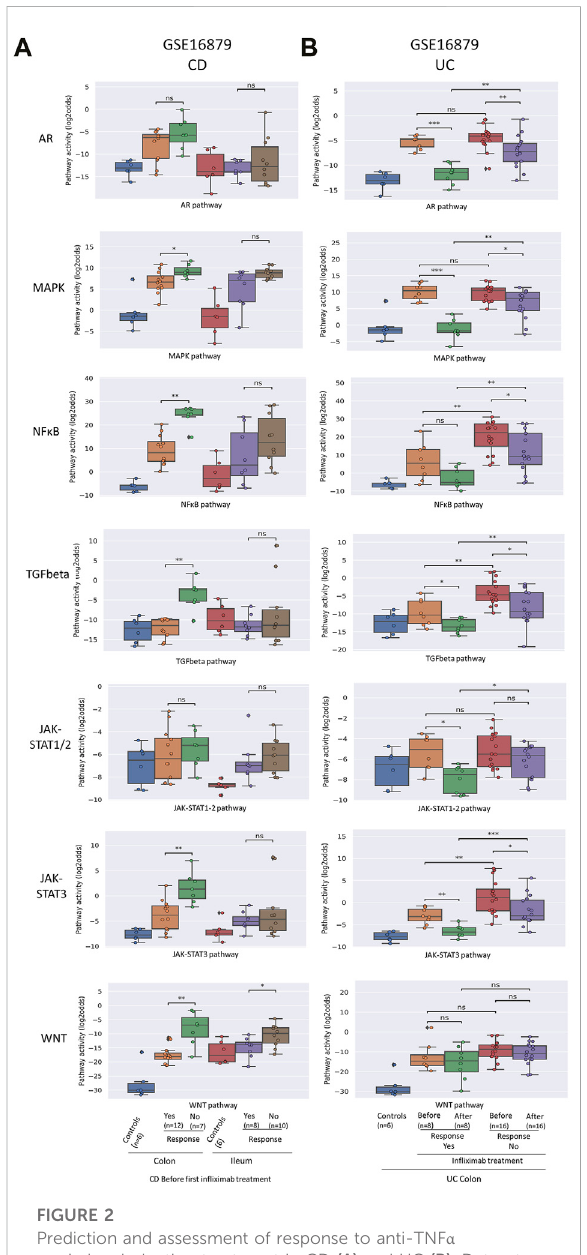
FIGURE 2 Prediction and assessment of response to anti-TNF α remission-induction treatment in CD (A) and UC (B) . Datasets GSE16879. STP activity analysis of intestinal mucosa samples for prediction of response to anti-TNF α remission induction treatment in patients with CD and UC. STP PAS before and after remission induction treatment. For details, see Methods. STP PAS are shown for the AR, MAPK, NF κ B, TGF β , JAK-STAT1/2, JAK- STAT3, and Wnt STPs. Two sided Mann – Whitney – Wilcoxon statistical tests were performed; p -values are indicated in